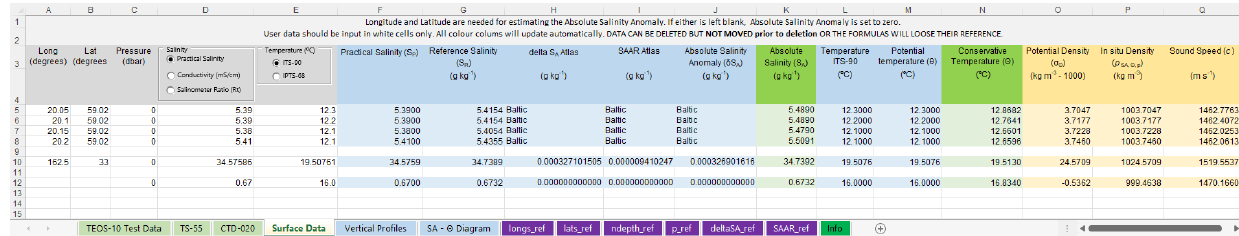
Figure 2. TEOS-10 Excel workbook (v.2.1) Surface Data tab. Surface data from different locations (location coordinates for each line). Four samples are from the Baltic Sea and one from the NW Pacific; the last sample (without long/lat coordinates) is from an